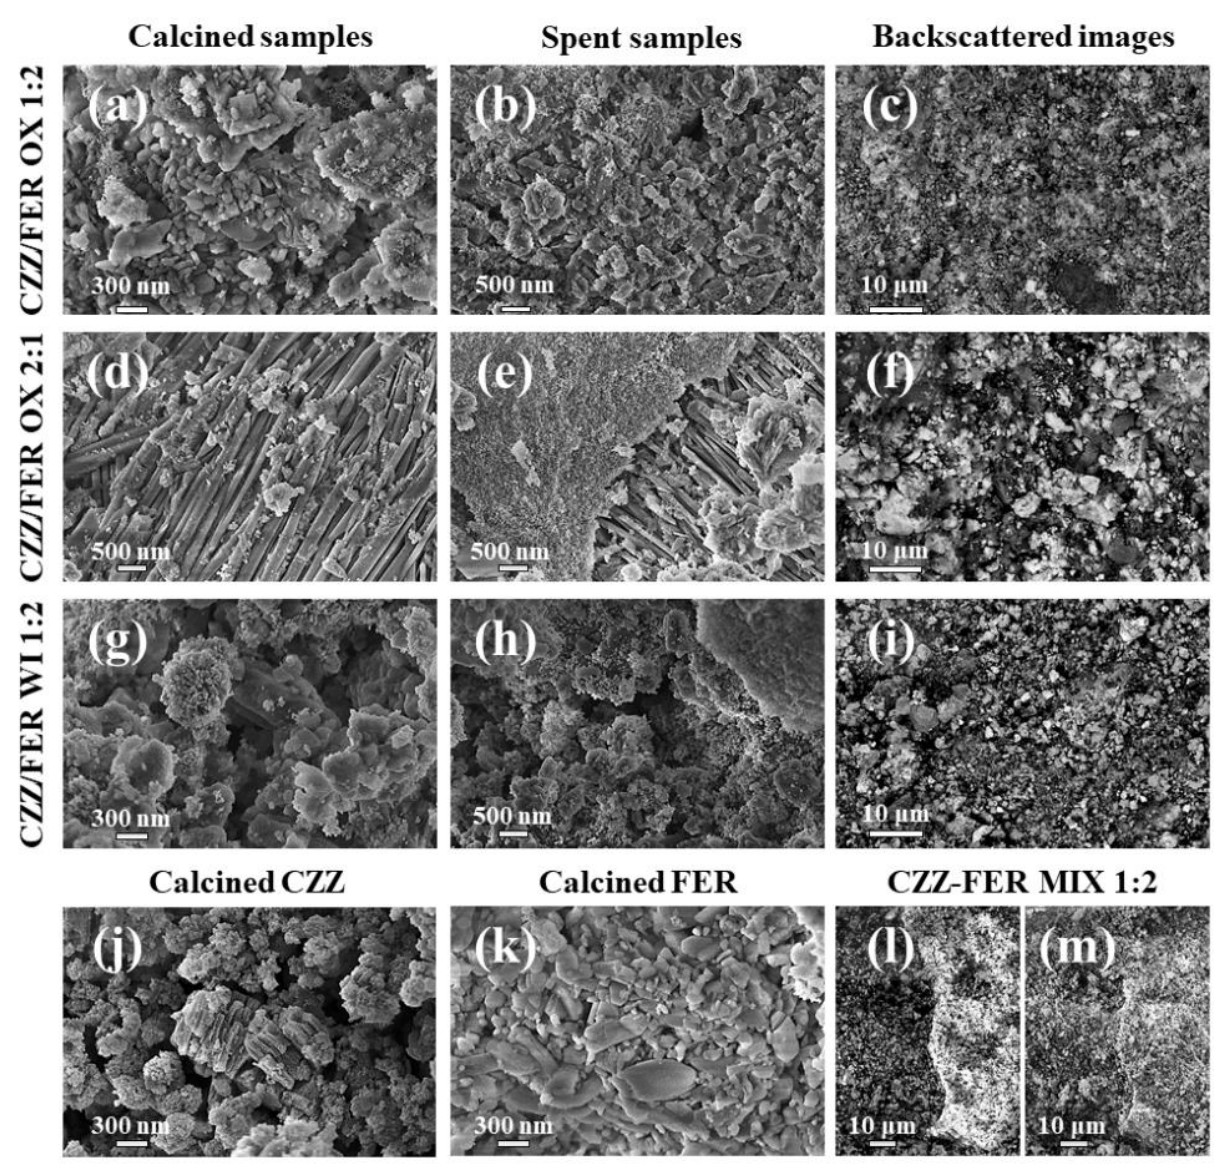
Figure 2. FESEM images of calcined samples: ( a ) CZZ/FER OX 1:2, ( d ) CZZ/FER OX 2:1, ( g ) CZZ/FER WI 1:2, ( j ) CZZ, ( k ) commercial FER and ( m ) CZZ-FER MIX 1:2. FESEM images of spent catalysts: ( b ) CZZ/FER OX 1:2, ( e ) CZZ/FER OX 2:1 and ( h ) CZZ/FER WI 1:2. Backscattered FESEM images of calcined samples: ( c ) CZZ/FER OX 1:2, ( f ) CZZ/FER OX 2:1, ( i ) CZZ/FER WI 1:2 and ( l ) CZZ-FER MIX